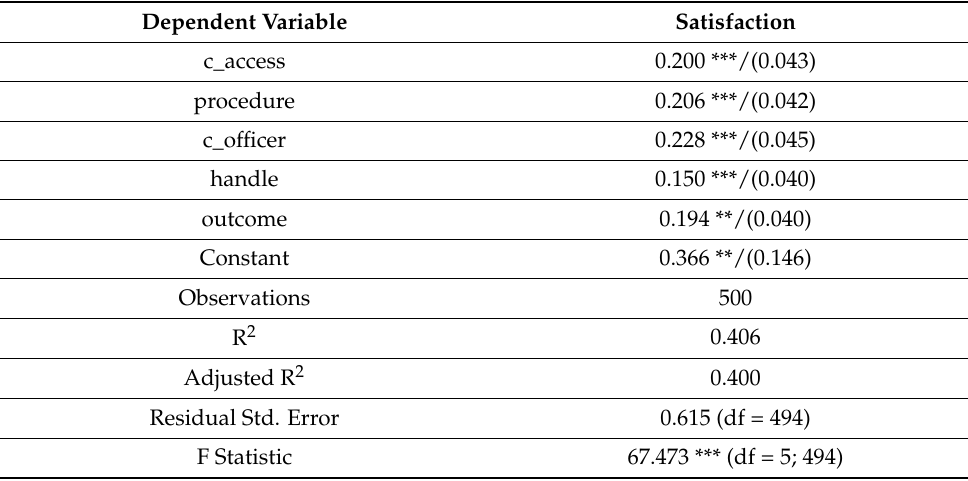
Table 4. The results of multiple linear regression analysis.